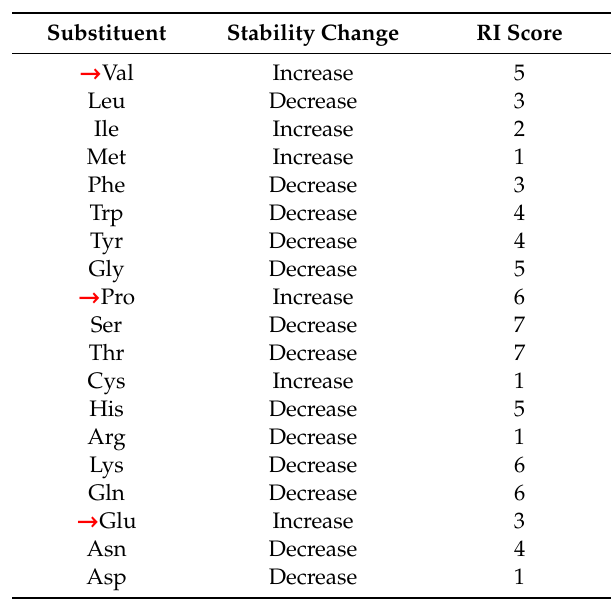
Table 2. The stability change and Reliability Index (RI) score upon amino acid residue substitution at critical point